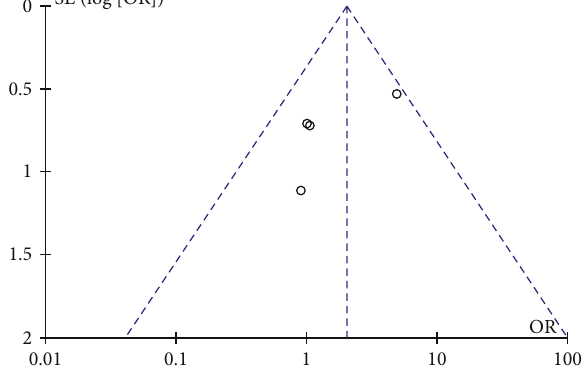
Figure 4: Funnel plot (IC